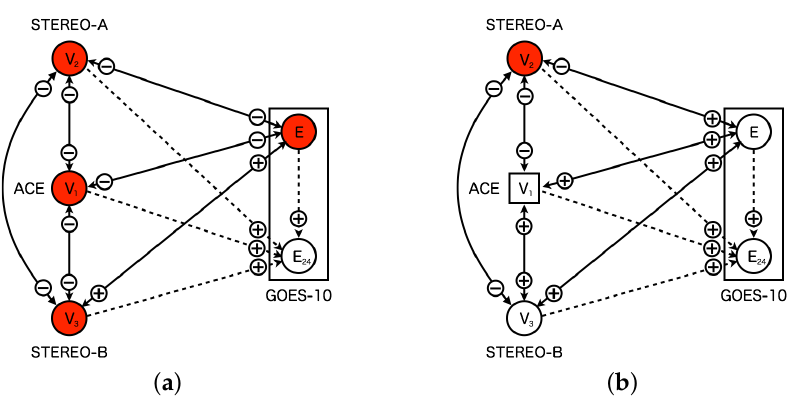
Figure 13. Network snapshot of the dynamic relational network for the test data shown in Figure 9. Figure ( a , b ) show the status of the nodes at 48 and 80 steps respectively. The circles and squares indicate the real and virtual sensor nodes respectively. The white (red) colored sensor nodes is normal (abnormal). The credibility for the normal status is larger than 0.5, otherwise abnormal. The rectangles indicate region of the satellite. The two sensors of GOES-10 is shown in the regions of the rectangles. The solid lines indicate the diagnosis flows of mutual diagnosis. The dashed line indicate diagnosis flows from real sensors to virtual sensors for prediction. The marks plus (minus) indicate diagnosis results as normal (abnormal) from the source nodes to the target nodes. ( a ) Step = 48 (After the real sensor for ACE failed); ( b ) Step = 80 (After the virtual sensor for ACE is